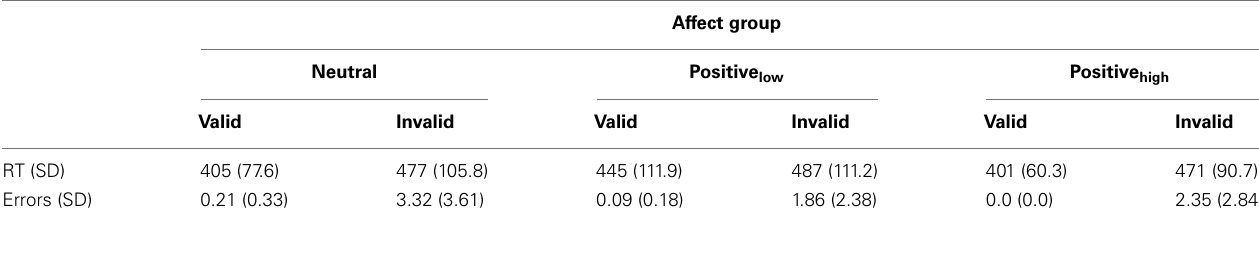
Table 2 | Mean RTs (in ms) and error rates (in %) in the spatial response cueing task of experiment 2 as a function ofAffect group and Cue